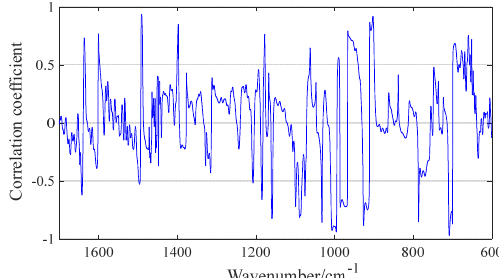
Figure 6. Correlation between IR and SBS content.